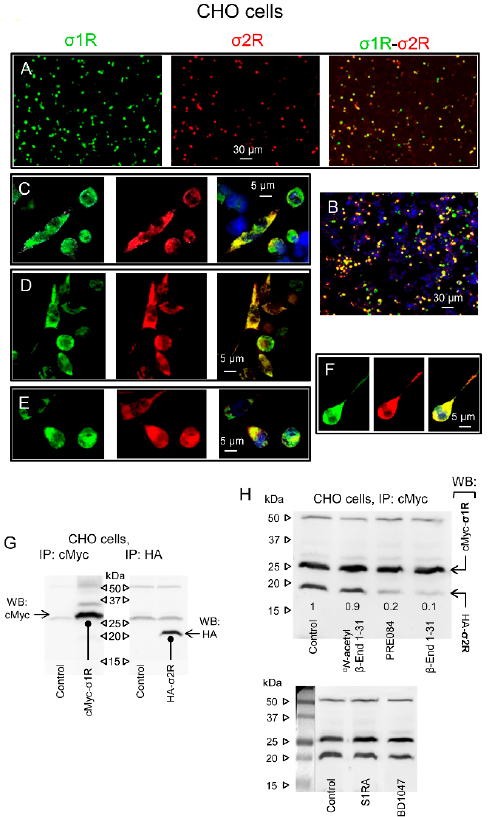
Figure 6. Physical interactions between σ 1Rs and σ 2Rs. Effect of β -End 1–31 and α N -acetyl derivative. ( A ) Single-wavelength and merged images of CHO cells cotransfected with cMyc- σ 1R and HA- σ 2R. The cells were fixed 48 h after transfection and analyzed by confocal laser scanning microscopy. Transient expression of proteins within the transfected cells was detected with anti-cMyc (green) and anti-HA (red) antibodies (original magnification 10 × ). The fluorescent signals reflect the expression of the proteins of interest. Scale bar: 30 µ m. ( B ) Nuclei stained with DAPI (blue). ( C – F ) Single- wavelength and merged images are enlargements of individual cells. Scale bar: 5 µ m. Lower panels: ( G ) Immunoprecipitation (IP) of tagged sigma receptor types from cotransfected CHO cells. Biotin- conjugated anti-cMyc and anti-HA antibodies precipitated sigma receptors as detected by Western blot analysis using antibodies that recognize either tag of the sigma receptor proteins. ( H ) σ 1R/ σ 2R coprecipitates from cultures incubated with β -End 1–31 (1 nM), α N -acetyl β -End 1–31 (1 nM), the σ 1R agonist PRE084 (100 nM) and the σ 1R antagonists S1RA (100 nM) and BD1047 (100 nM). The control was assigned an arbitrary value of 1, and the changes observed in the test groups were referred to as the control. Representative blots are